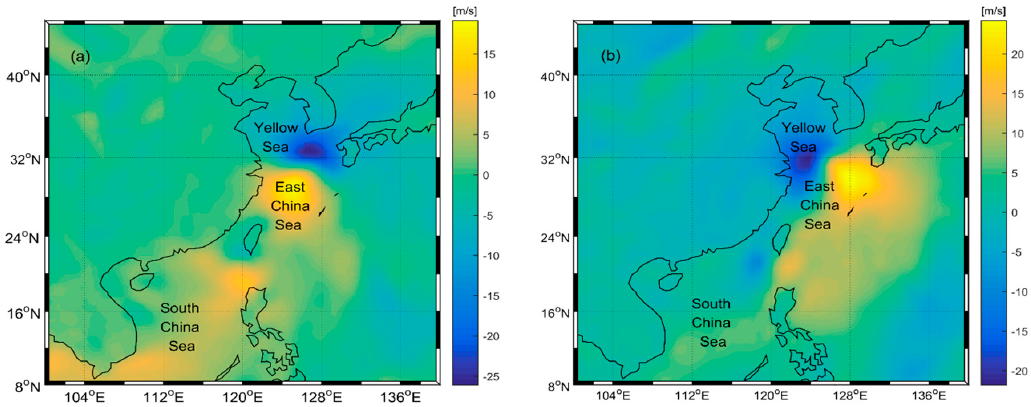
Figure 1. ERA-Interim wind speeds: ( a ) east-west direction and ( b ) south-north direction in Chinese waters. The ERA-Interim wind products are acquired on 20 August 2012 at 12:00:00 UTC from ECWMF website.